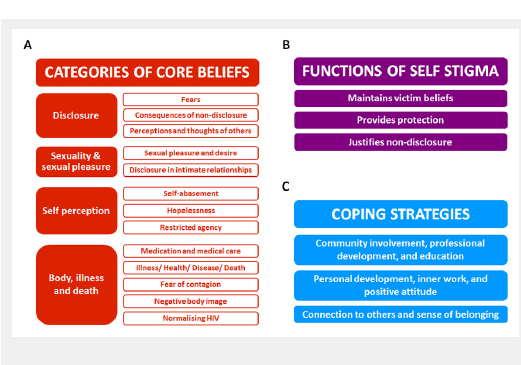
Framework for qualitative analysis of interview data. Three main areas of analysis are shown: Categories of core beliefs (A, red), Functions of self-stigma (B, magenta) and Coping strategies (C, blue). Emergent themes were organised into categories (solid boxes), and subcategories where required (open